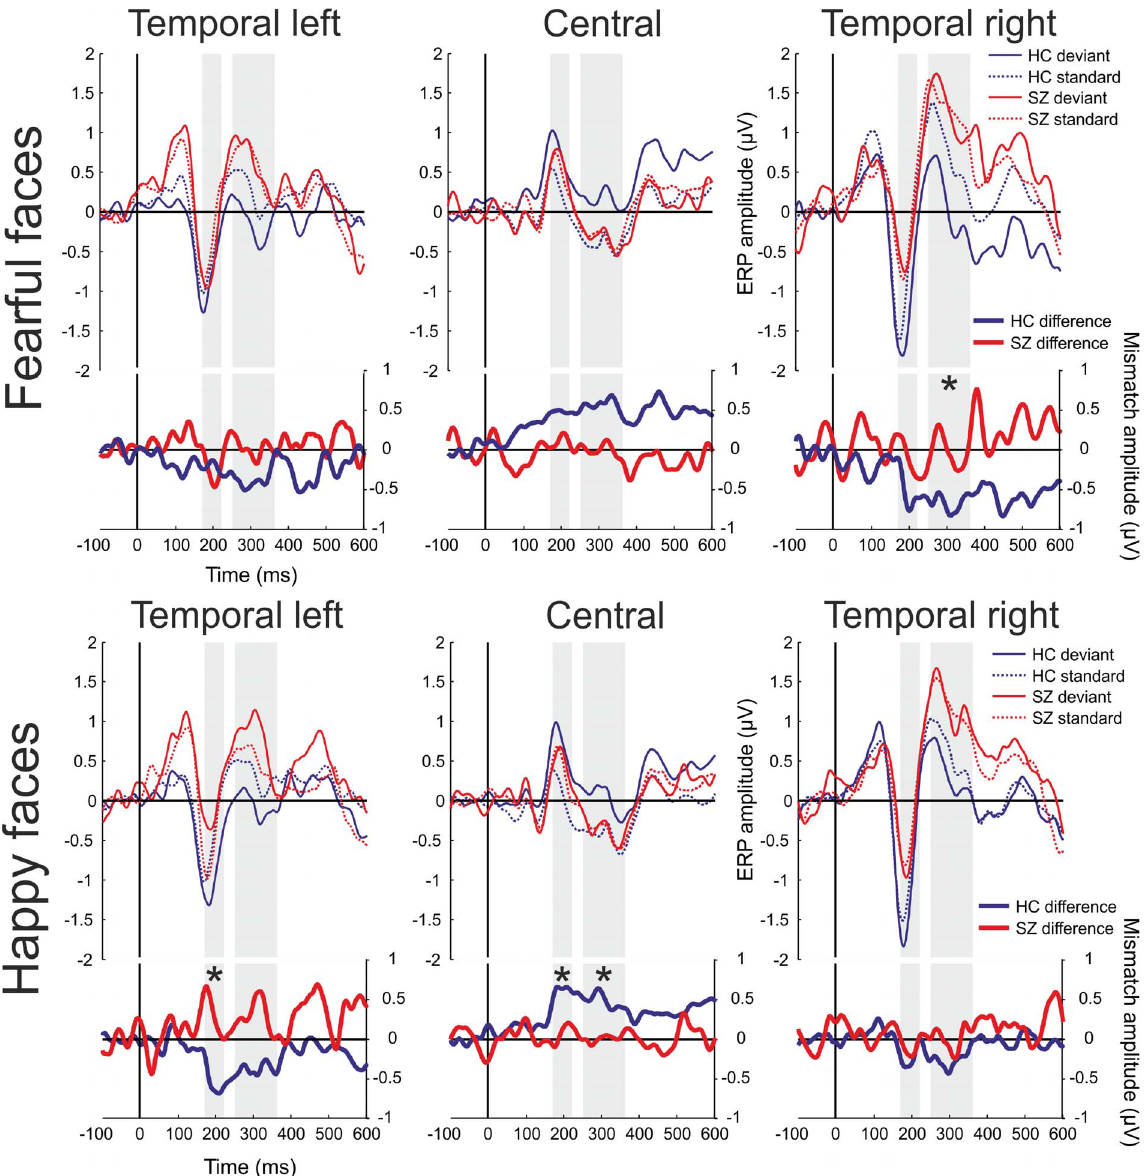
Figure 2. Event-related potentials and mismatch waveforms by region. HC=Healthy Controls, SZ=Patients with Schizophrenia. Upper panel: ERPs for fearful faces; lower panel: ERPs for happy faces. Shaded intervals indicate time windows of amplitude measurements. Only those ROIs were used for between-group comparison where the mismatch waveform in at least one of the study groups differed significantly from zero after correction for multiple testing. Asterisks mark time windows where significantly larger mismatch responses were found in the healthy control group compared to the patients.